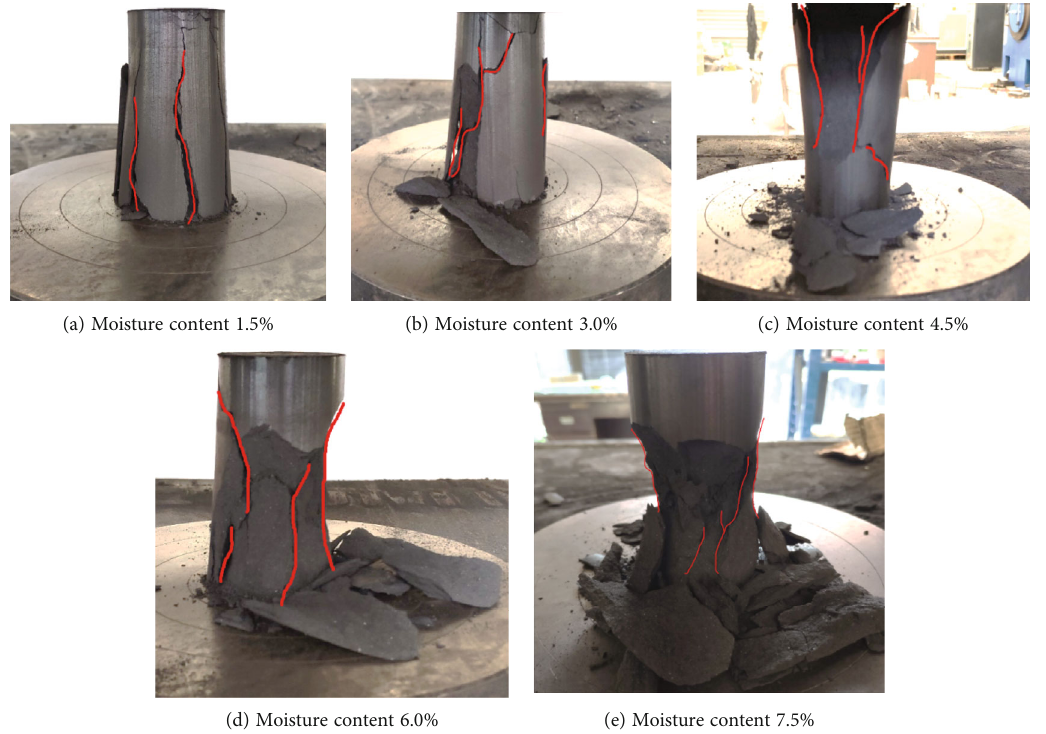
Figure 9: Failure characteristics of coal samples with di ff erent moisture